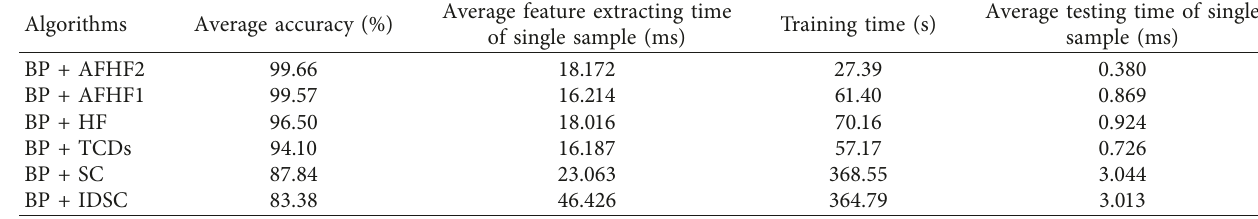
Table 4: Experimental results on simulated shaft orbit dataset by BP neural network.